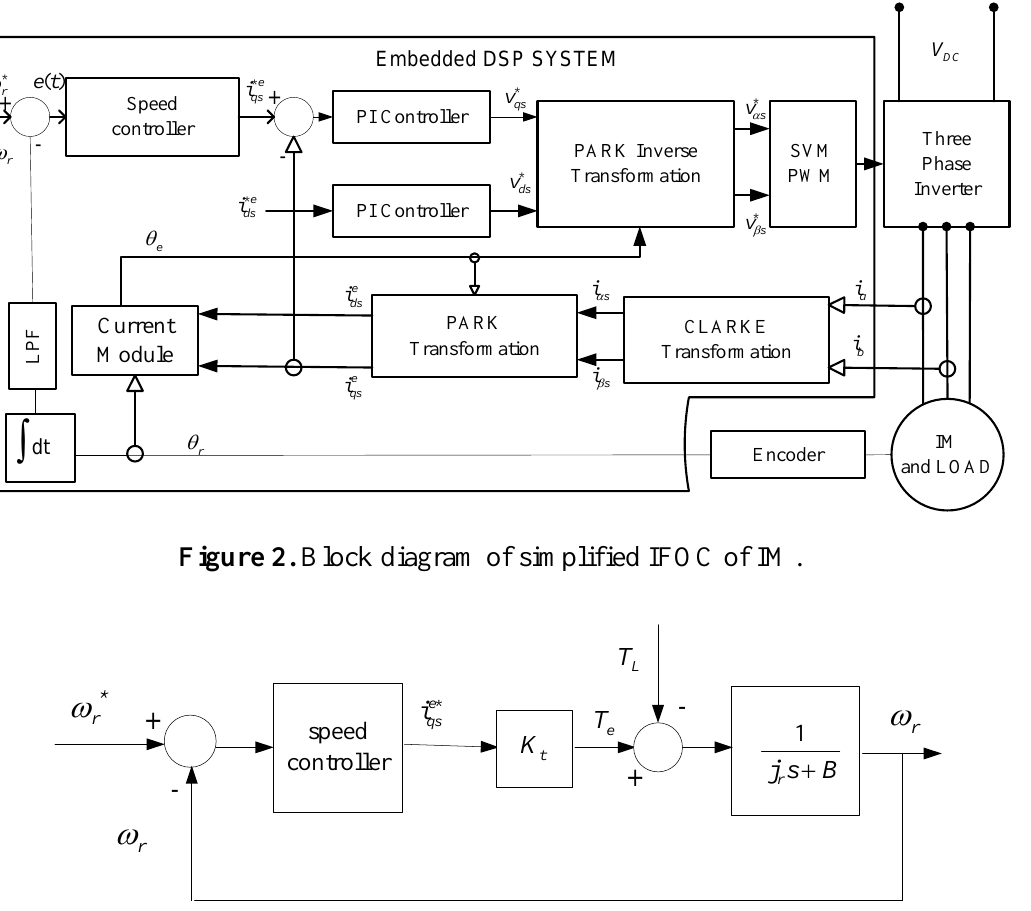
Figure 1. Block diagram of a closed loop sensord IFOC based IM drive.